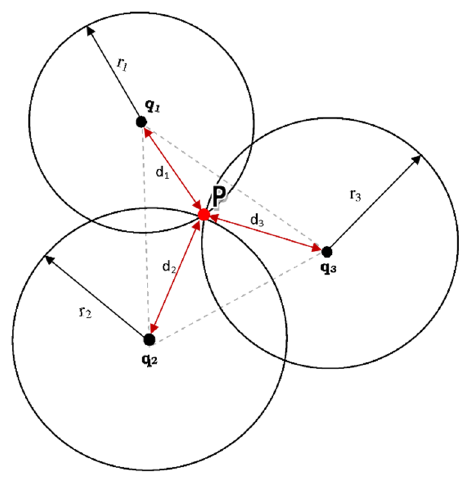
Figure 1. Intersection of three anchor nodes and new coordinate p .